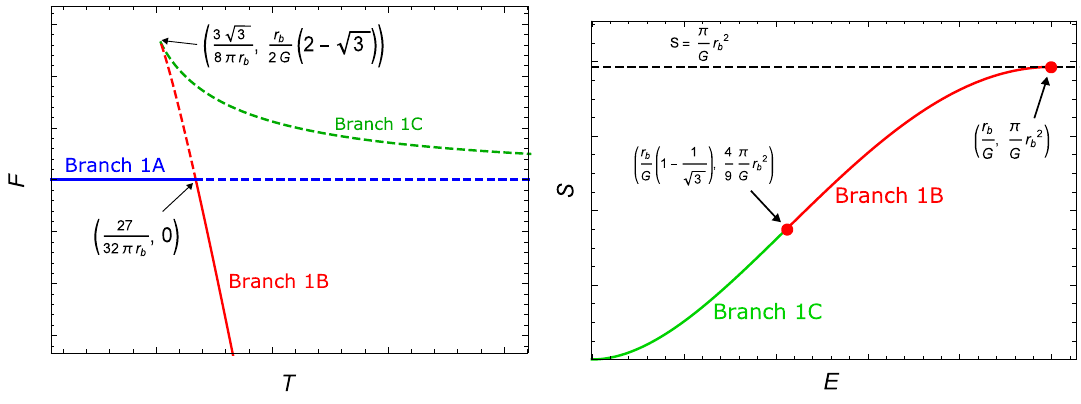
Figure 2 . ( Left ) Qualitative behavior of free energies of saddles 1A, 1B, and 1C. The portion that does not give dominant contribution is dashed. ( Right ) Qualitative behavior of entropy as the function of energy. The maximum energy is r b